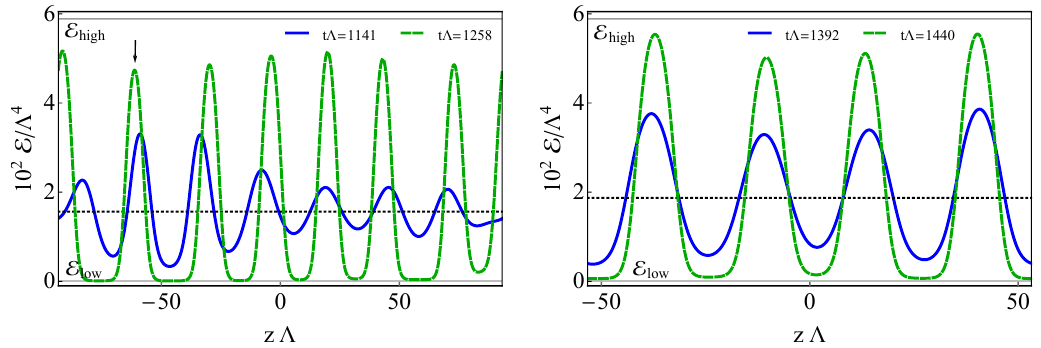
Figure 8 . Snapshots of the energy densities of (cid:12)gure 4 at the end of the linear regime (solid blue) and at the end of reshaping period (dashed green). The arrow on the left plot indicates the peak that corresponds to (cid:12)gure 12. The green dashed curves precisely correspond to the peaks observed at early times in (cid:12)gure 11. Notice that the maxima of the pro(cid:12)les have some velocity which will translate into the initial velocity of the structures